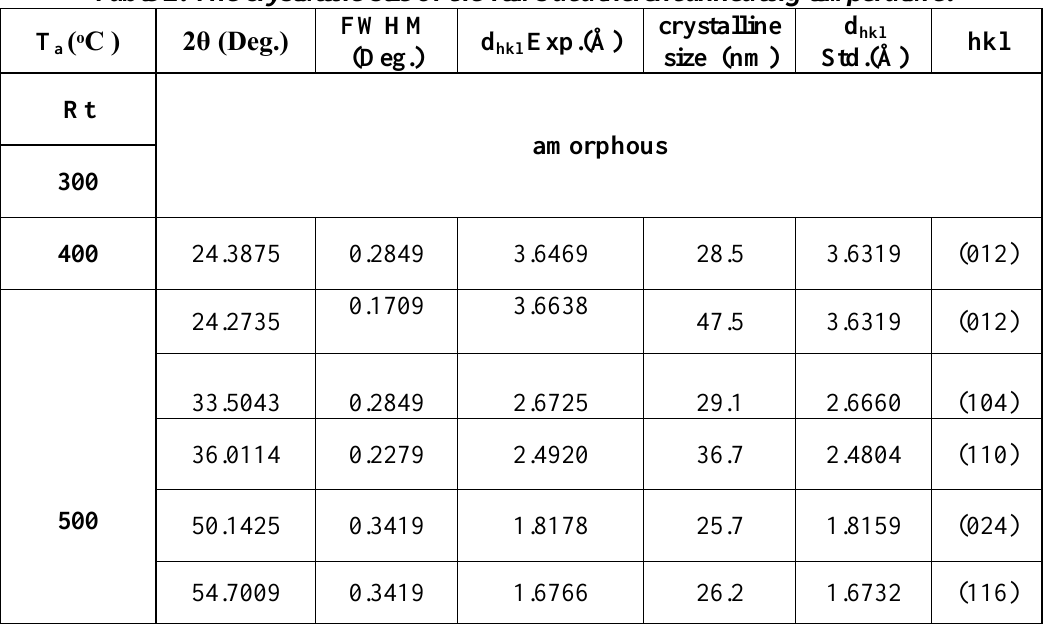
Fig. 3: X-ray diffraction of Cr Table 2: The crystalline size of the films at different annealing